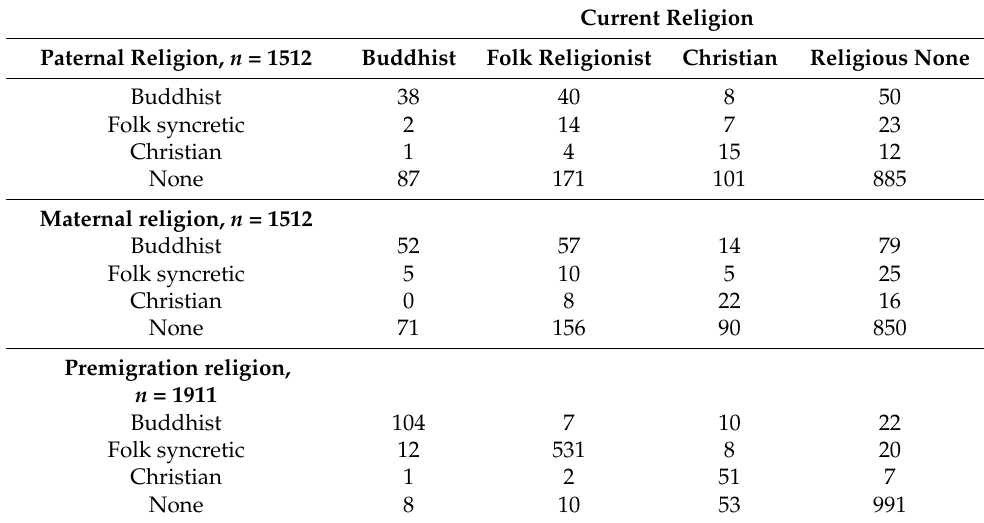
Table 2. Cross-tabulated comparison of religious conversion, by intergenerational and personal changes in religious